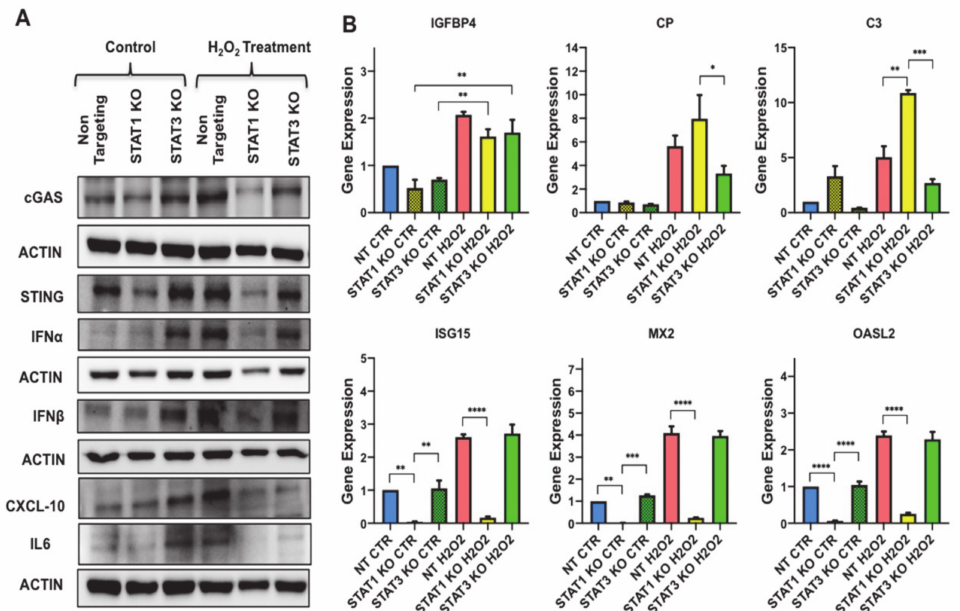
Figure 8. STAT1 functionally interacts with cGAS/STING to drive the expression of CXCL10 and antiviral response genes and STAT3 negatively regulates this interaction. ( A ) Western blot assessing the protein levels of cGAS, STING, IFN α , IFN β , CXCL10 and IL6 in untreated NT, STAT1 KO, and STAT3 KO preadipocytes vs. H 2 O 2 treated counterparts as indicated. Actin was used as loading control. Results are represented as means ± SEM from three independent experiments. ( B ) Gene expression analysis of most significantly upregulated SASP molecules in untreated NT, STAT1 KO, and STAT3 KO preadipocytes vs. H 2 O 2 treated counterparts as indicated including IGFBP4, CP, and C3 along with interferon signalling- related genes (ISG15, MX2 and OASL2). Results (Relative expression) are presented as means ± SEM from three independent experiments. * p ≤ 0.05, ** p ≤ 0.01, *** p ≤ 0.001, **** p ≤ 0.0001 (ANOVA with post hoc Tukey